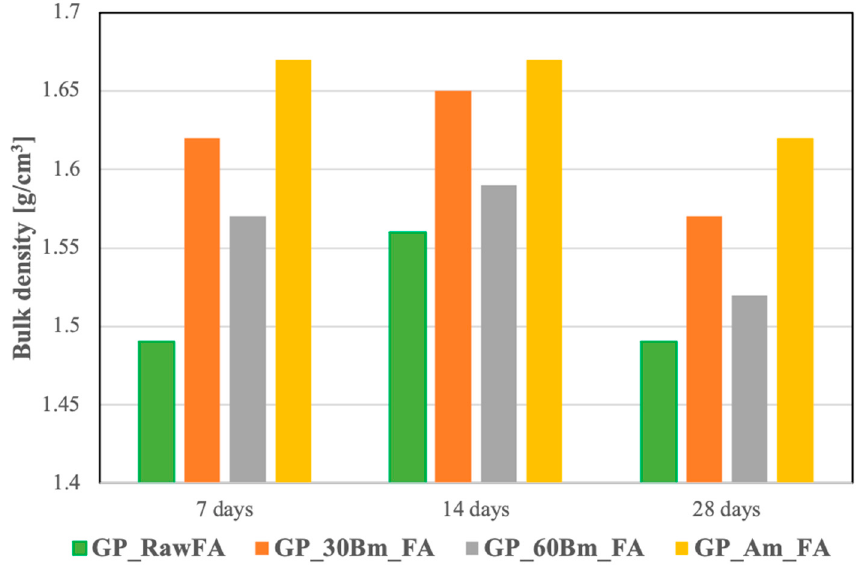
Figure 10. Bulk densities of the various